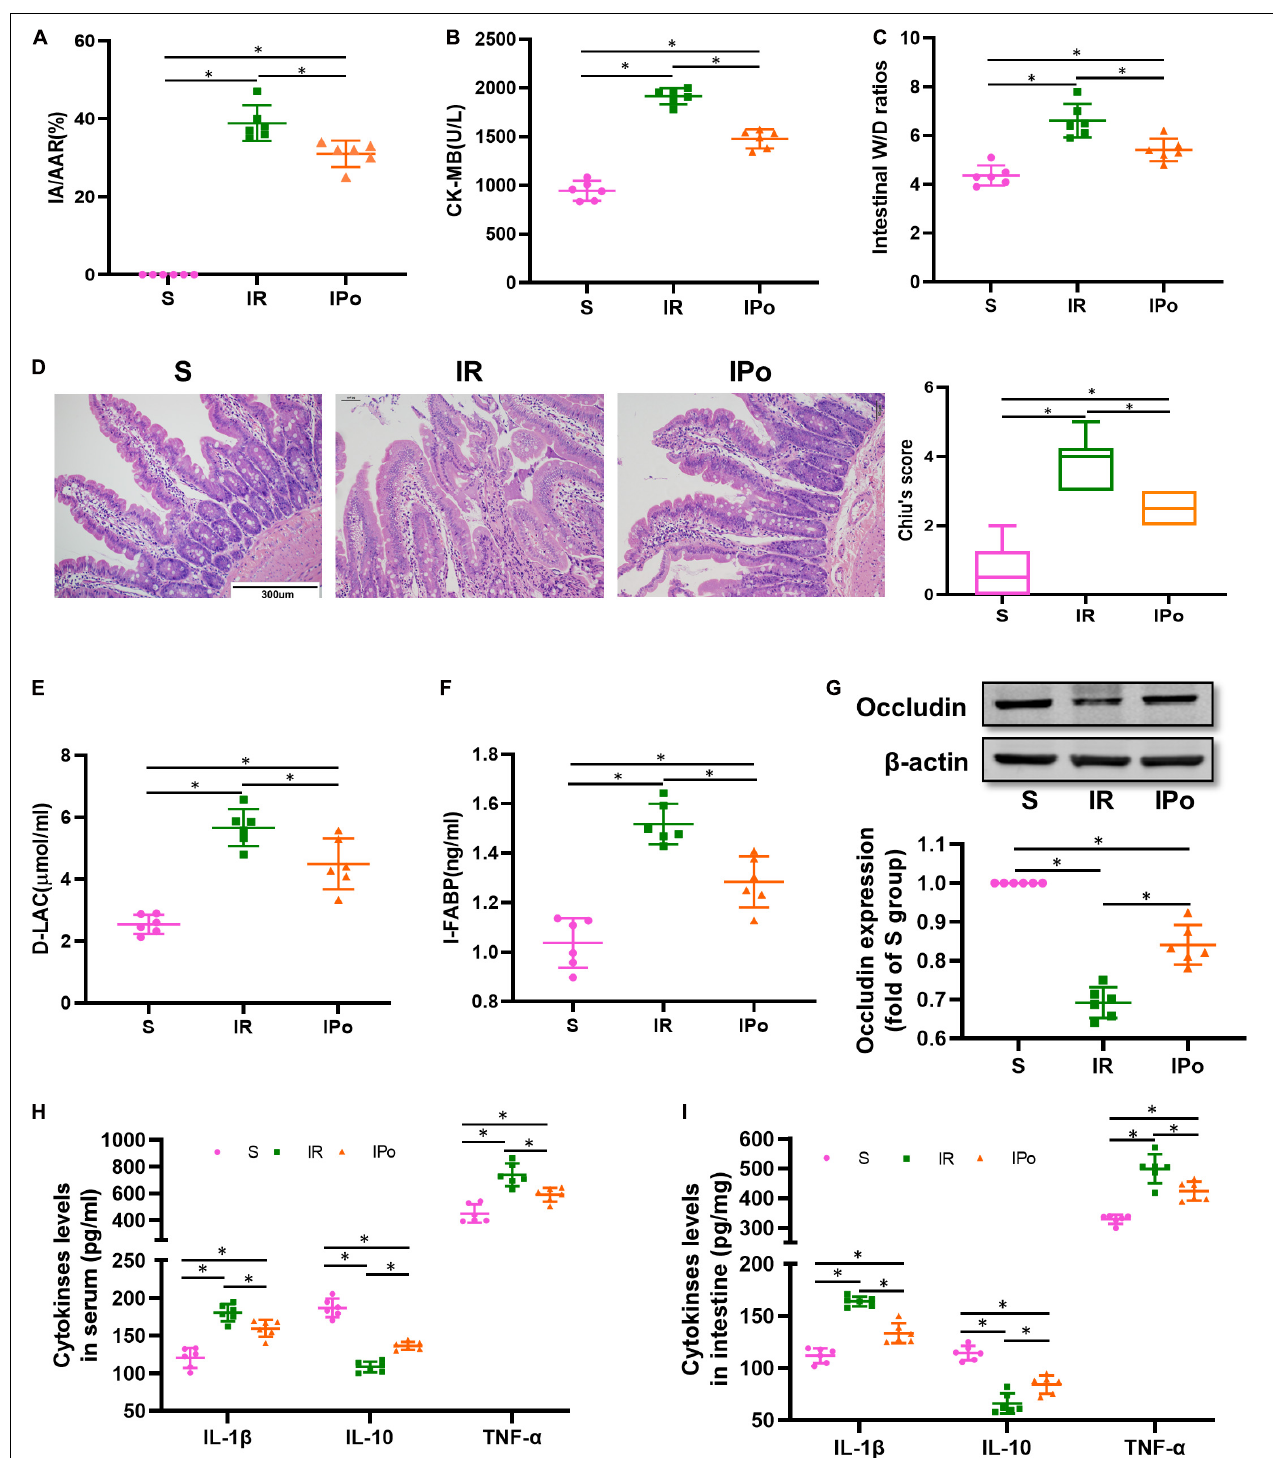
FIGURE 2 | Ischemic postconditioning alleviated myocardial IR-induced myocardial and intestinal injury. (A) Infarct area relative to the area at risk (IA/AAR × 100%). (B) Serum CK-MB level. (C) Intestinal water W/D ratios. (D) Histopathologic changes of the small-intestinal mucosa under light microscopy imaging (H&E staining, Scale bar = 300 µ m). Intestinal mucosa injury was graded by Chiu’s score. Serum concentrations of D-LA (E) and I-FABP (F) . (G) Expression of occludin. The levels of inflammatory cytokines (IL-1 β , IL-10, and TNF- α ) in the serum (H) and intestine (I) . β -actin were detected as loading control. S, Sham; IR, ischemia reperfusion; IPo, ischemic postconditioning. Data are mean ± SD or Box-Whisker’s plot ( n = 6); * P < 0.05.